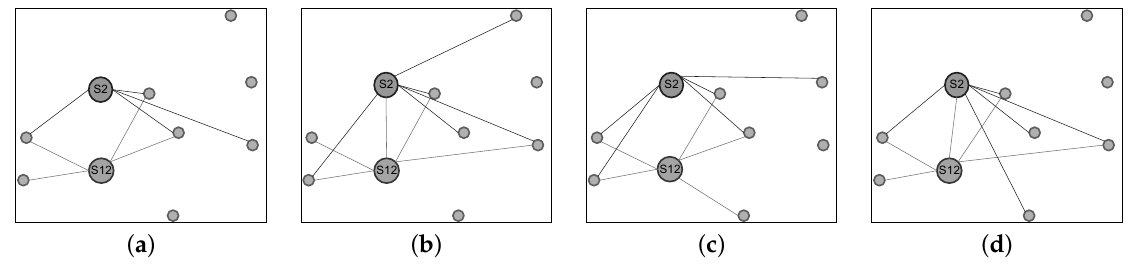
Figure 14. Temporal variation of the topology of the Jiufeng wireless sensor network (shown here are only links incident to nodes S2 and S12). ( a ) The 10th minute; ( b ) The 20th minute; ( c ) The 30th minute; ( d ) The 40th minute.